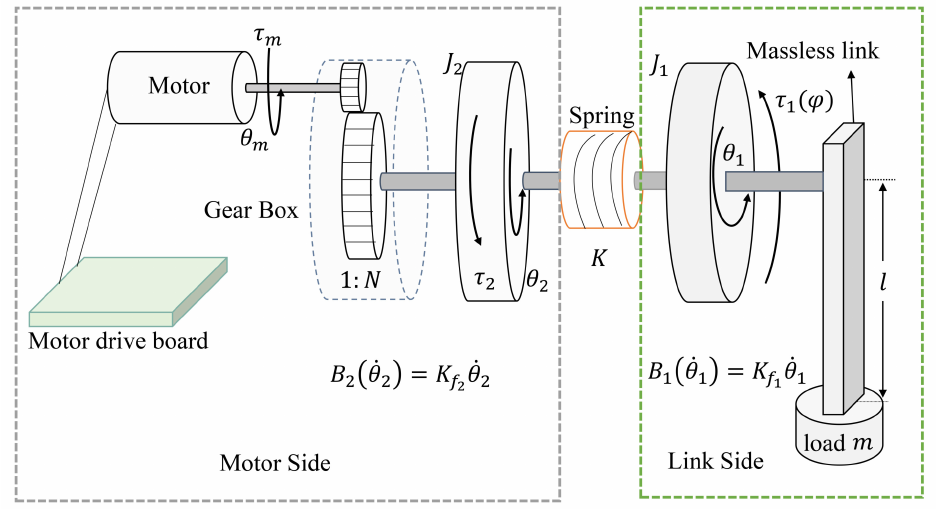
Figure 1. The architecture of single-link FJ robot